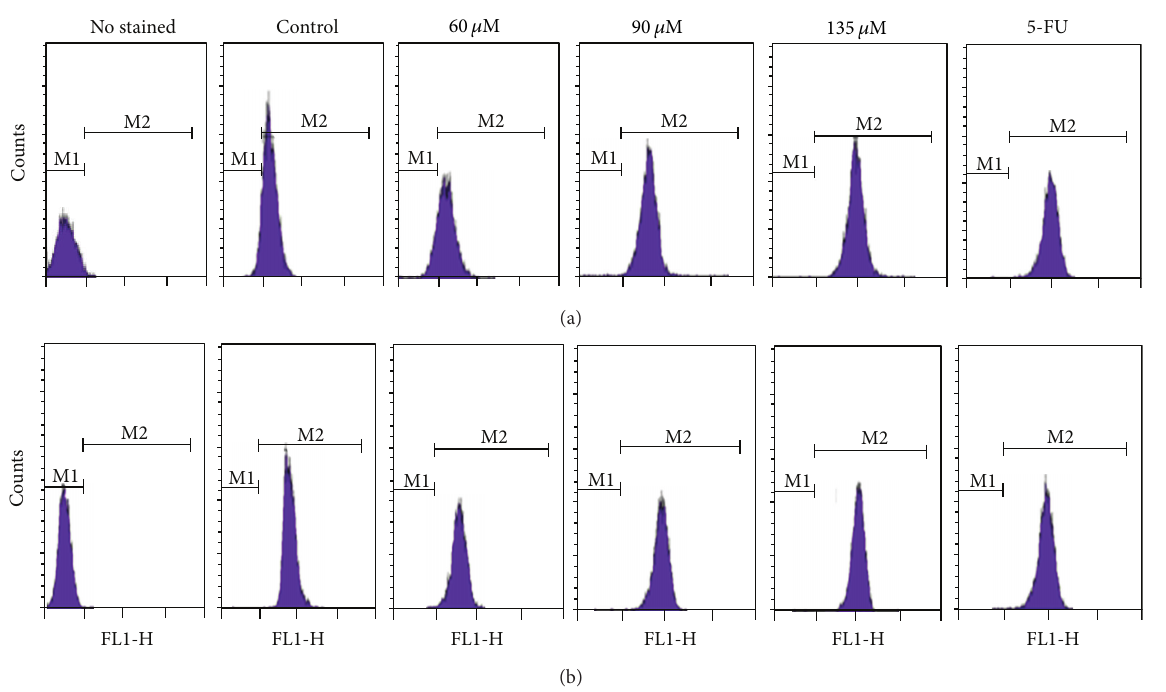
significantly. The results indicate that both complexes 1 and 2 induced proliferative suppression of BEL-7402 cells were via the induction of apoptosis, and the induced apoptosis effect of 2 is stronger than that of 1